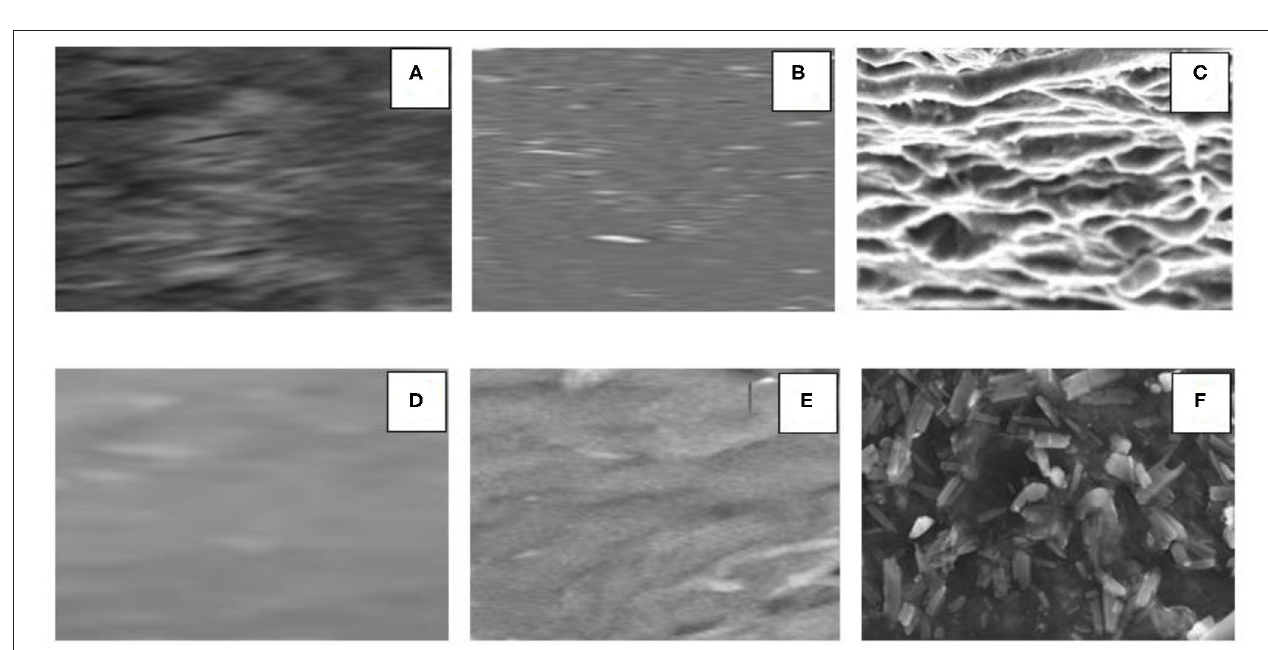
FIGURE 7 | Cross-sectional view of the surface profile of a BtC: (A) MSGPvA with PCL and AMA, (B) MSGPvA from Harsojuwono et al. (2021), and (C) the starch:carrageenan (25:75) with 1% glycerol and 6% PVA from Hartiati et al. (2021); longitudinal surface profile of (D) MSGPvA with PCL and AMA, (E) MSGPvA from Harsojuwono et al. (2021), and (F) the starch:carrageenan (25:75) with 1% glycerol and 6% PVA from Hartiati et al. (2021). All images with × 1,000 magnification.